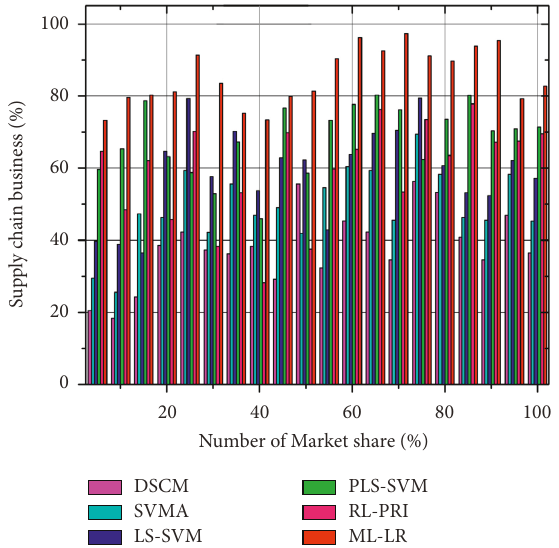
Figure 6: Commercial Bank’s supply chain in credit risk assessment.